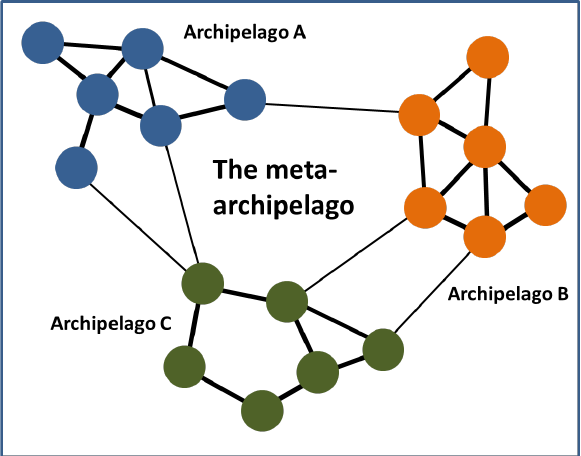
Figure 3. The meta-archipelago: in this hypothetical case, a constellation of three archipelagos that have and continue to exhibit a meaningful level of information exchange (e.g., propagules) signified by the lines of varying thickness joining the islands; exchanges among constituent archipelagos should occur significantly less often than the level of exchange typical within an archipelago, but significantly more than with other areas. Inspired by a sketch in Poisot